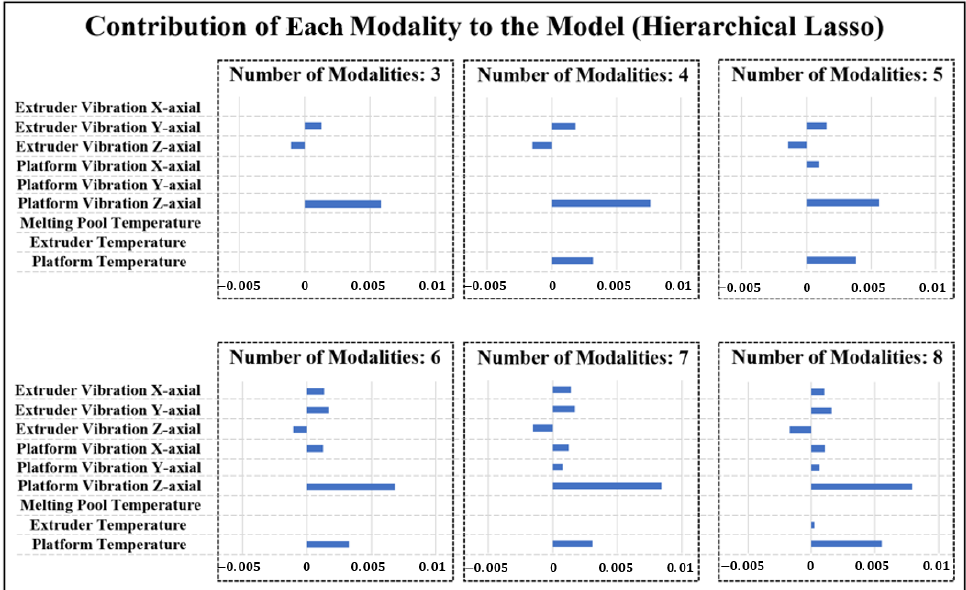
Figure 7. Contribution of each Modality for Flatness Prediction with Different Numbers of Modalities in Hierarchical